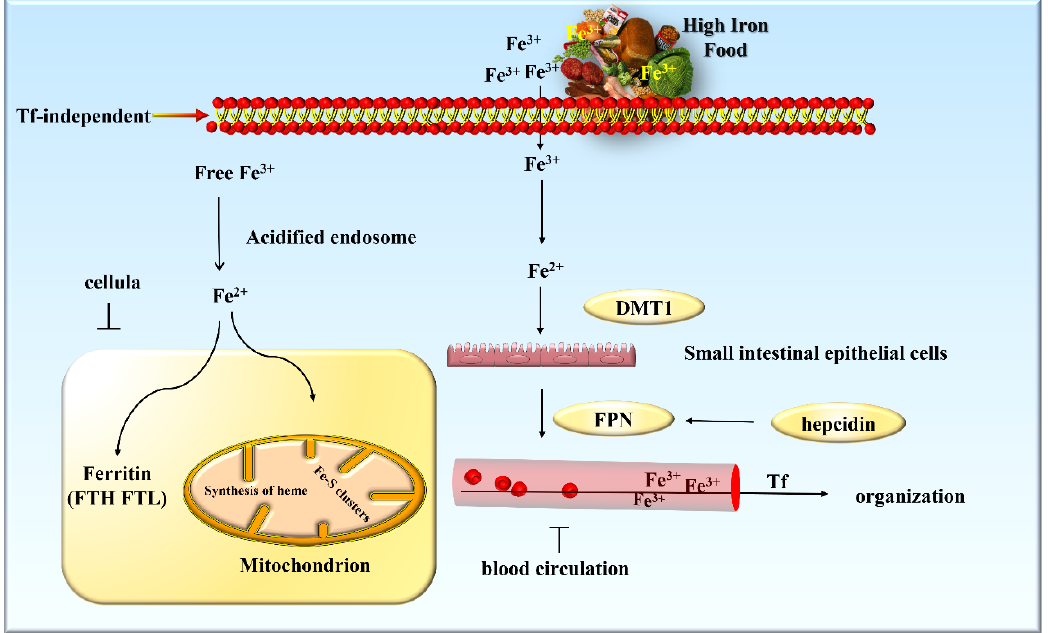
Figure 2. A schematic model describing iron absorption and storage in the body.